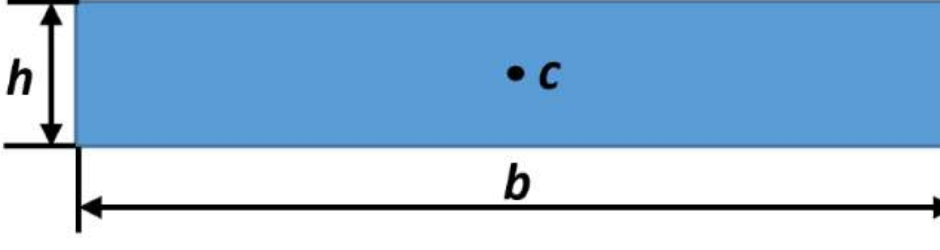
Figure 13. Diagram of moment of inertia.